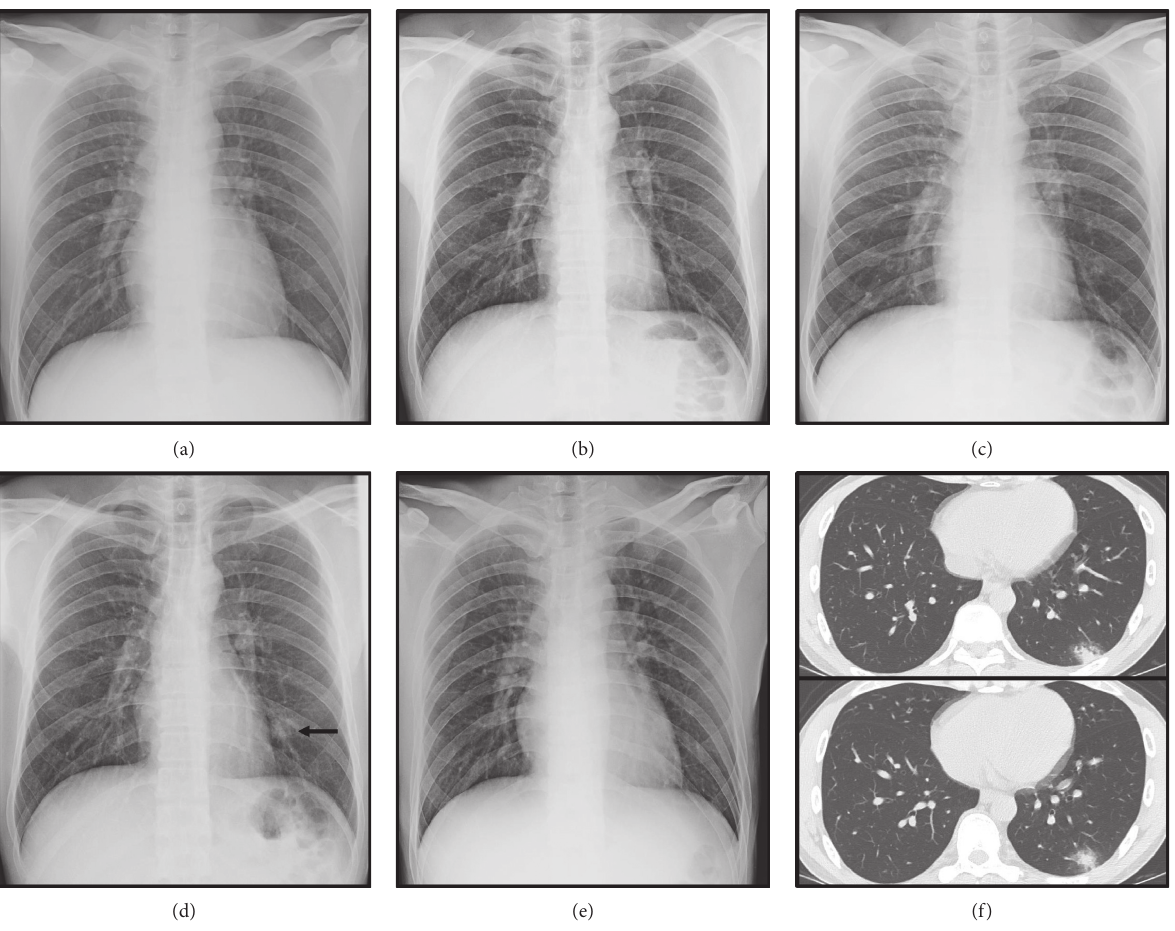
Figure 2: Images in a 37-year-old male patient with acute myeloid leukemia whose serum galactomannan test was positive. (a) Baseline chest film shows no opacity. (b) Chest film on first day of febrile neutropenia (ANC � 11 μ L) shows no opacity. (c) Chest film on third day of febrile neutropenia (ANC � 17 μ L) still shows no opacity. (d) Chest film on fourth day of febrile neutropenia (ANC � 0 μ L) shows new opacity at left lower lung (arrow). (e) Chest film on seventh day of febrile neutropenia (ANC � 2511 μ L) shows improvement of lower lung opacity. (f) Axial CT chest on the fourth day of febrile neutropenia reveals a nodular-like consolidation with surrounding ground-glass attenuation, representing a CT halo sign. This case was evaluated as true-positive chest radiograph and CT chest.